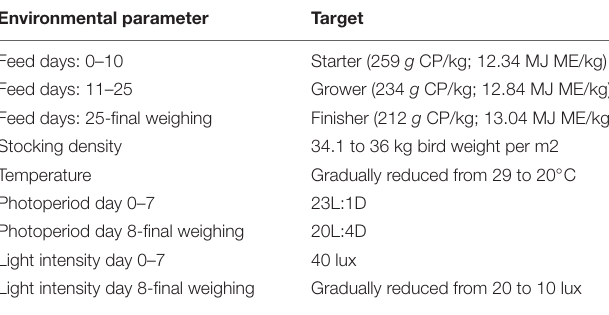
TABLE 2 | Environmental parameters for all farms with birds under examination for both studies reported in this paper. Environmental